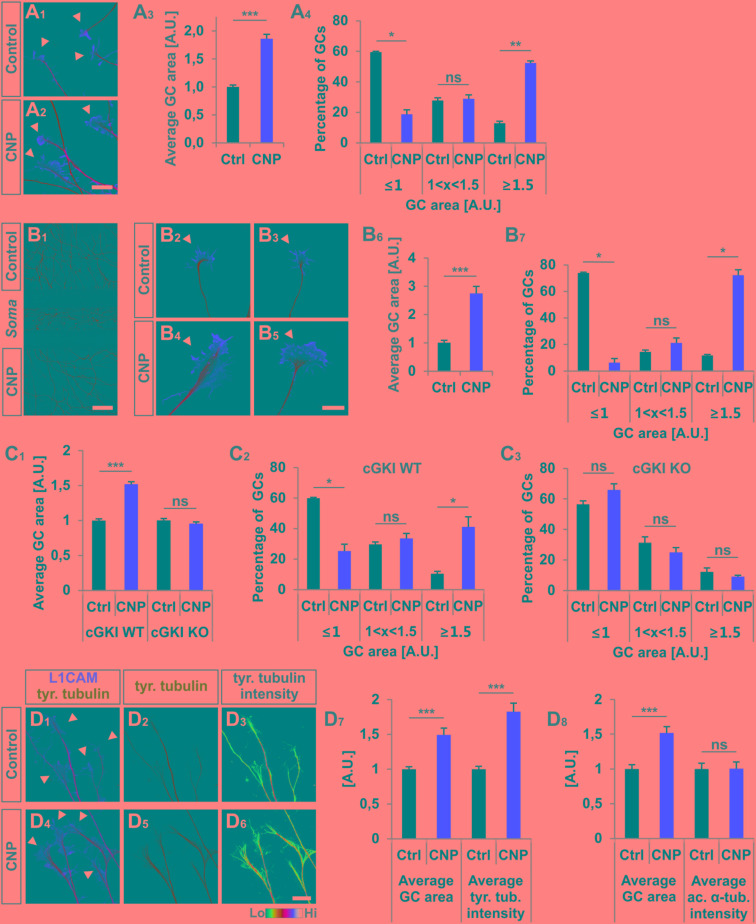
CNP induced a growth cone enlargement via cGKI. (A1–A4) E12.5 mouse DRG explants were grown for 16–20 h on laminin1 followed by treatment with (500 nM) or without CNP for 1 h. For visualization cultures were stained for α-tubulin (green) and F-actin (red). Arrow heads in A1 and A2 indicate growth cones. Scale bar, 20 μm. (A3) Quantification of growth cone area in confocal images using ZEN Blue edition software. Control n = 258 growth cones; CNP n = 180 growth cones from three independent experiments. (A4) Percentages of growth cone areas that were classified into three groups according to their area. Growth cones were compared to the normalized area value of the control. They were either equal or smaller than the average value 1 (≤1, small growth cone), up to 50% larger than this value (1 < x < 1.5, medium growth cones) or equal or larger than 50% of this value (≥1.5, large growth cones). (B1–B7) Similar results on growth cone enlargement of E12.5 mouse DRG dissociated cells were obtained using a three microfluidic chamber culture system in which CNP was applied to one axonal compartment and the second axonal compartment served as control. Cell somata are in the middle chamber. (B6,B7) Quantification as described for (A3,A4) (green neurofilament-M). Control chamber n = 87 growth cones; CNP-containing chamber n = 65 growth cones, three independent experiments. Scale bar in (B1) 500 μm; in (B2–B5) 20 μm. (C1–C3) CNP-induced enlargement of the area of growth cones requires cGKI (E12.5 DRG explants). (C2,C3) Growth cones from E12.5 wild type (WT) and cGKI-deficient mice treated with CNP or left untreated were classified into three groups as described in A4. cGKI wild type control n = 480 growth cones; cGKI wild type with CNP n = 319 growth cones; cGKI knockout control n = 250 growth cones; cGKI knockout with CNP n = 349 growth cones. Four independent experiments. (D1–D8) CNP-induced growth cone enlargement is accompanied with an increase of tyrosinated tubulin. (D1–D6) Control and CNP treated growth cones from E12.5 mouse DRG explants were stained with anti-tyrosinated tubulin and counterstained with anti-L1CAM. Scale bar, 20 μm. (D7,D8) Quantification of tyrosinated and acetylated α-tubulin. Tyrosinated tubulin: n = 118 growth cones (control) and 49 growth cones (CNP), three independent experiments; acetylated tubulin: n = 69 growth cones (control) and 73 growth cones (CNP), three independent experiments. p < 0.0001 (∗∗∗), p < 0.001 (∗∗), p < 0.05 (∗), or p > 0.05 (ns), unpaired (A3,B6,C1,D7,D8) and paired (A4,B7,C2,C3) two-tailed t-test. Error bars represent SEM. A.U., arbitrary unit; GC, growth cone; KO, cGKI knockout; WT, wild type.